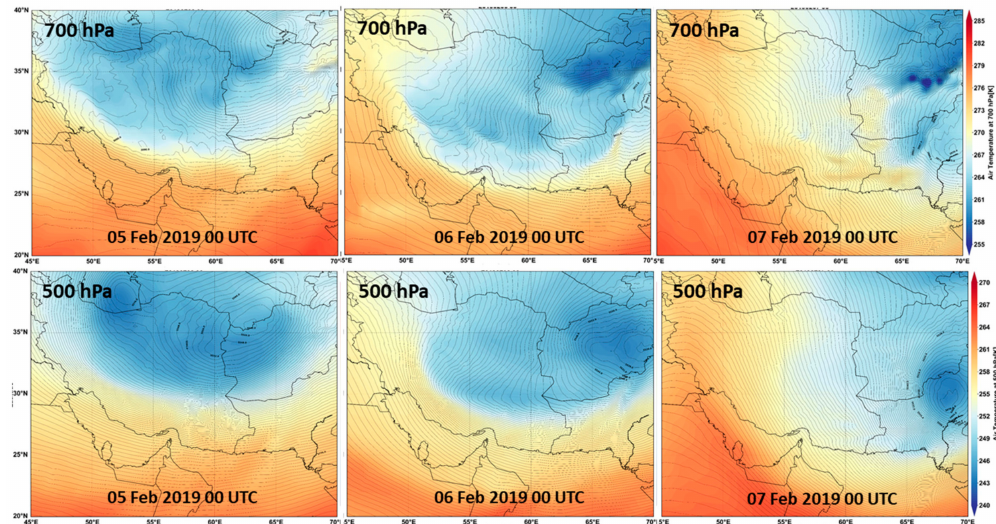
Figure 5. Air temperature at 700 hPa (upper row) and 500 hPa (bottom row) over southwest Asia on 5–7 February 2019 according to ERA-Interim reanalysis. The contours correspond to geopotential height variations at the same